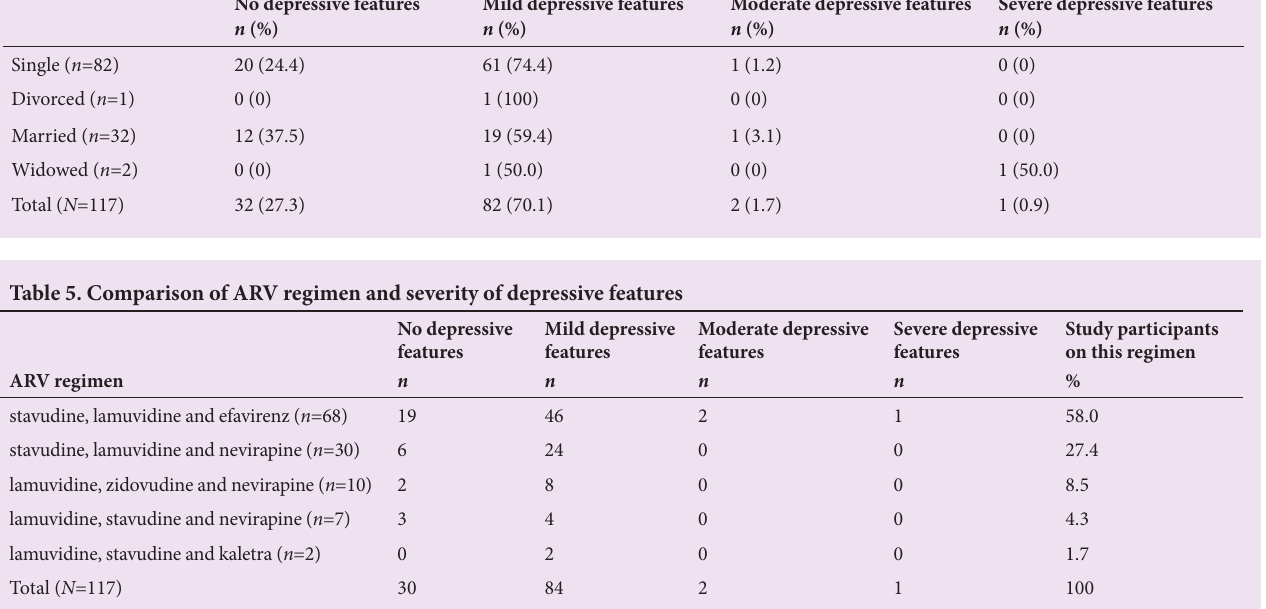
No depressive features n (%)